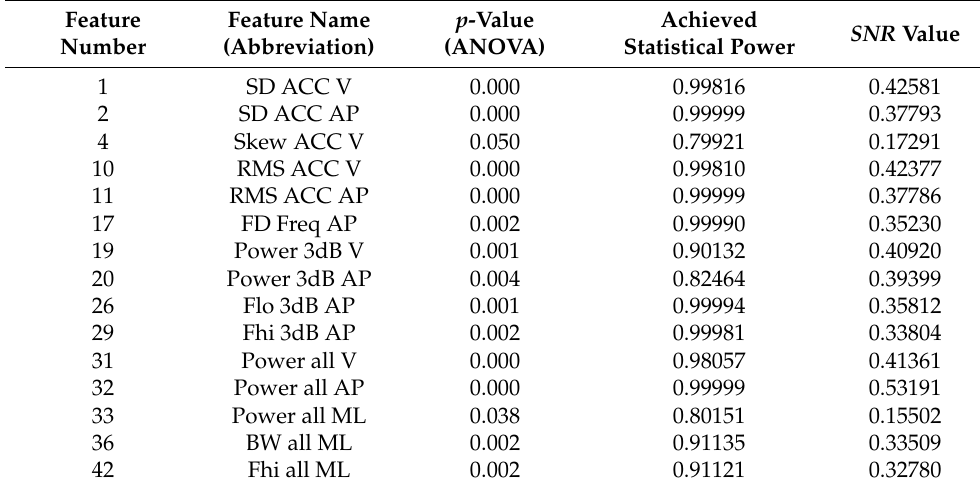
Table 2. List of statistically significant features and signal-to-noise ratio ( SNR )